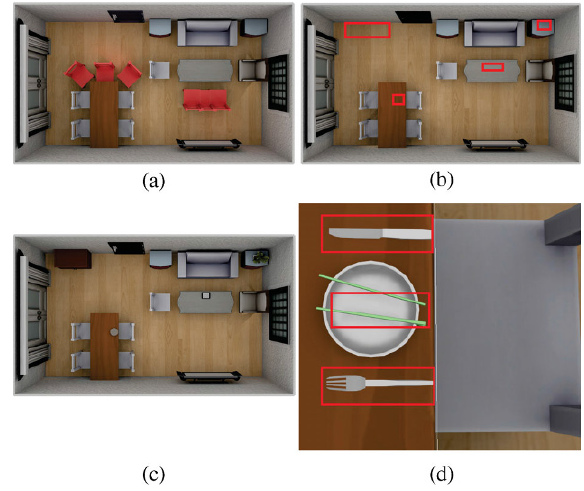
Fig. 6 Typical inference tasks. (a) Finding a proper placement for a user-selected instance. (b, c) Retrieving instances for selected placements. (d) A typical failure in retrieving instances for selected placements: both knife & fork and chopsticks are added.